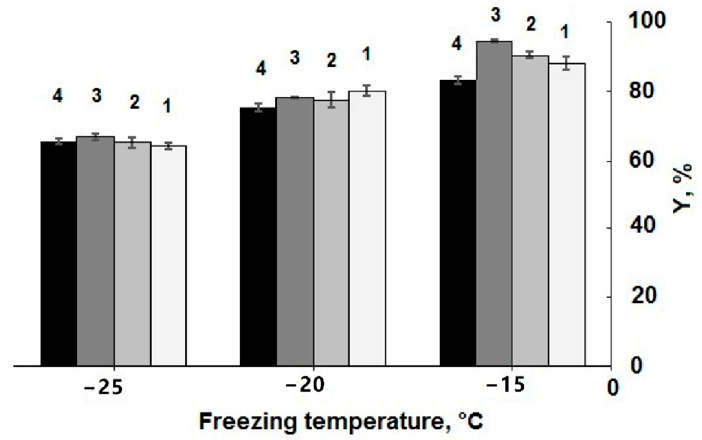
Figure 1. Values of the gel-fraction yield ( Y ) for the cryogels prepared from the initial solutions with different blood serum proteins concentration (75.0 ( 1 ), 62.5 ( 2 ), 50.0 ( 3 ), and 37.5 ( 4 ) mg/mL) by their freezing at − 15, − 20, and − 25 °C.